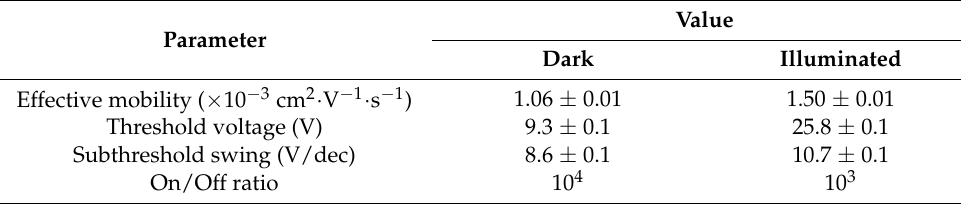
Figure 1. ( a ) Schematic view of the CuPc organic field ‐ effect transistor and ( b ) the micrograph illustrating the electrode topology with channel width 𝑊 and channel length 𝐿 . ( c ) Transfer characteristics and ( d ) Output characteristics of CuPc OFET device in dark and under illumination. The transfer characteristics were carried out for a drain ‐ source voltage of − 40 V, whereas the output characteristics were recorded for a gate ‐ source voltage that varied from 0 to − 40 V (step 5 V). Table 1. CuPc OFET device parameters.